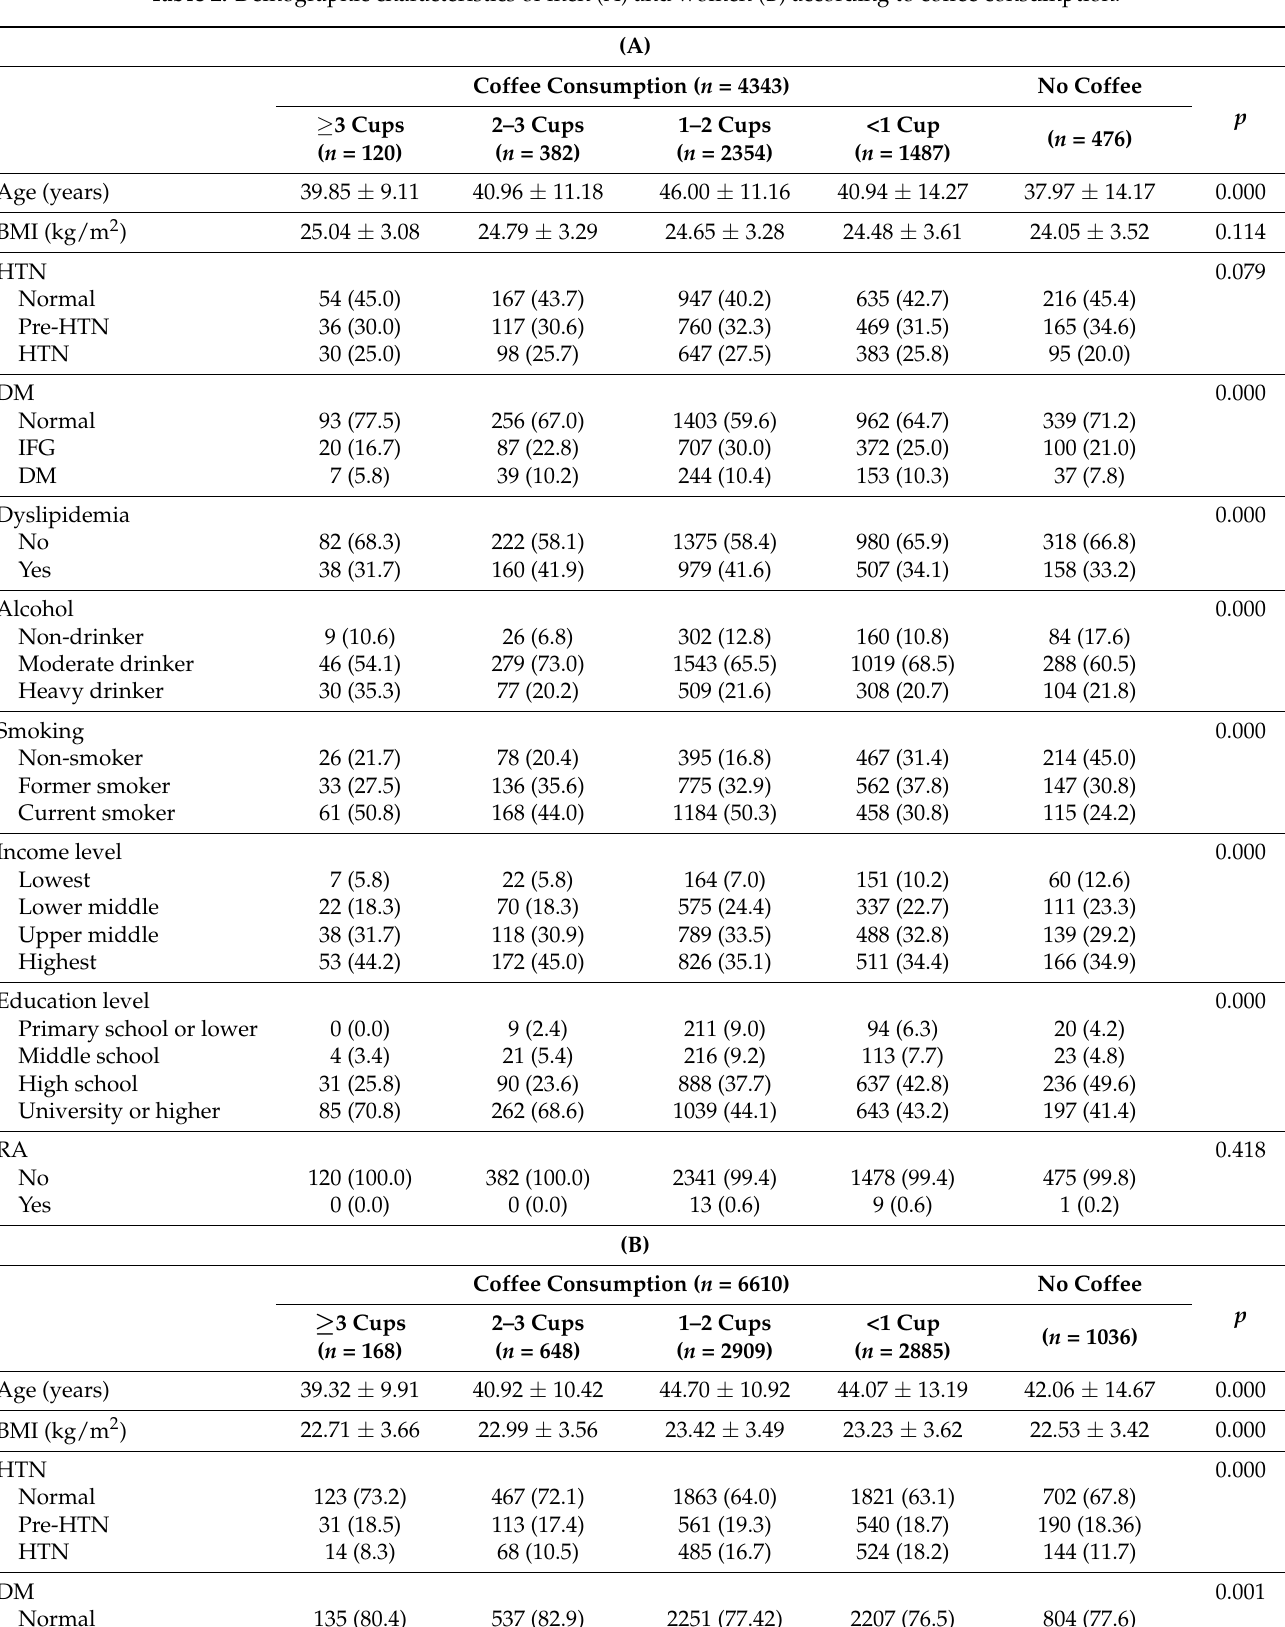
Table 2. Demographic characteristics of men (A) and women (B) according to coffee